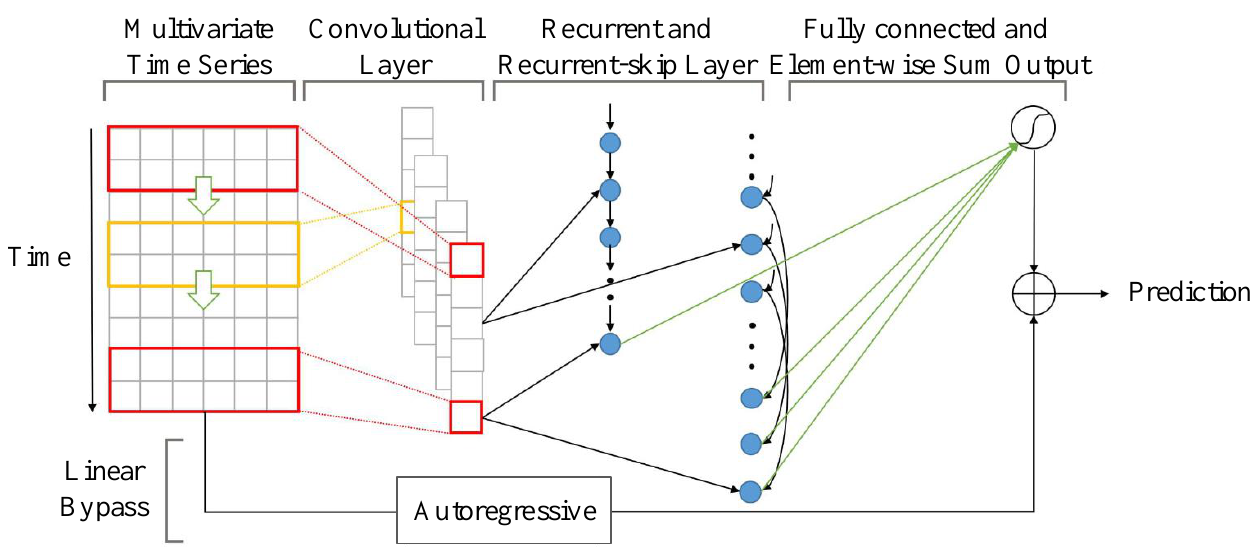
Figure 2. LSTNet